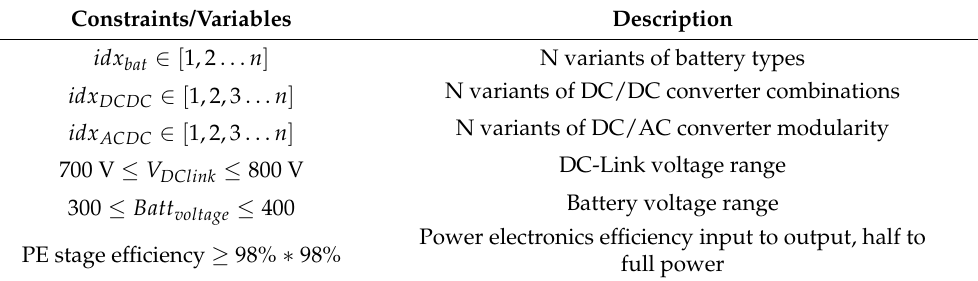
Table 4. Specifications and constraints for PCS-2.